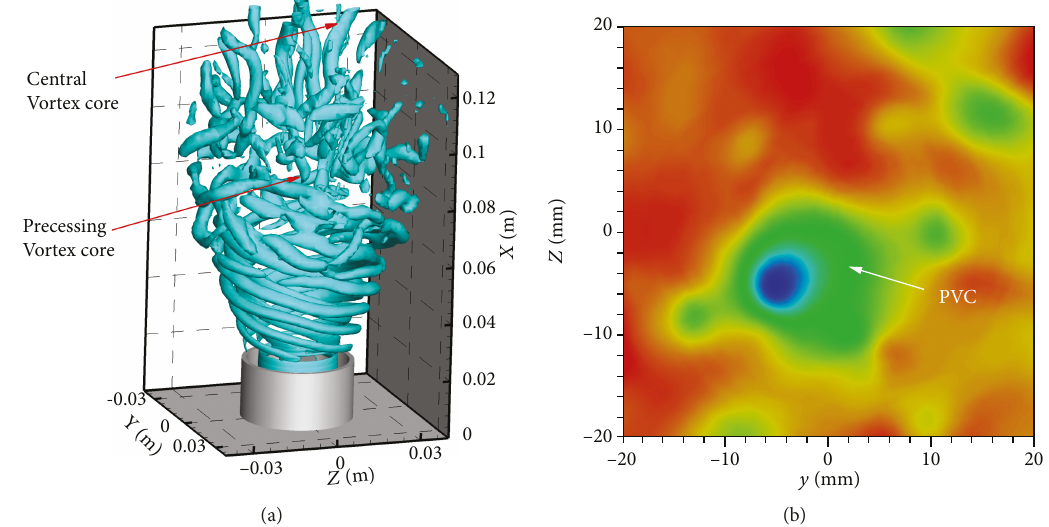
Figure 14: Instantaneous vortex structures (a) and PVC (b) for the reacting